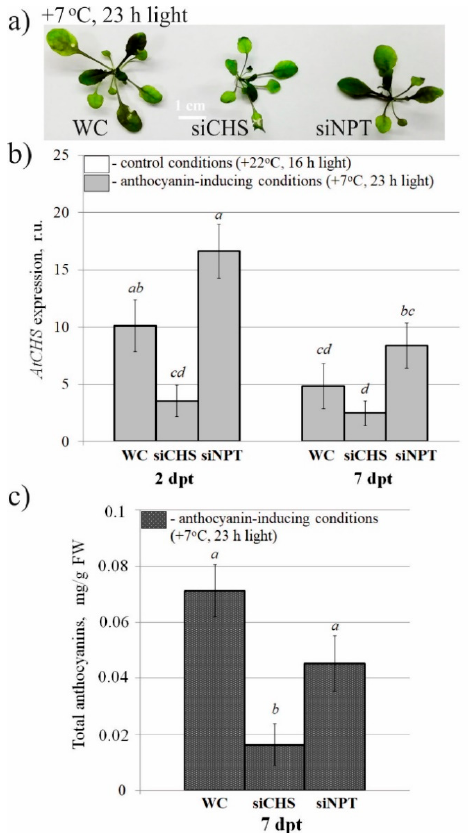
Figure 5. The effect of external AtCHS - and NPTII -encoding siRNAs on AtCHS mRNA level and total anthocyanin content in Arabidopsis thaliana . ( a ) Arabidopsis plants grown under control (+22 °C, 16 h light, upper panel) and anthocyanin-inducing (+7 °C, 23 h light, lower panel) conditions for seven days after treatment with sterile water or synthetic siRNA. ( b ) Quantitative real-time PCR measuring relative mRNA levels of endogenous AtCHS in the leaves of A. thaliana treated with water or synthetic siRNAs. ( c ) HPLC results of the total anthocyanin content in the leaves of A. thaliana grown at the control and anthocyanin-inducing conditions. WC— A. thaliana treated with sterile water; siCHS— A. thaliana treated with synthetic AtCHS -siRNAs; siNPT— A. thaliana treated with NPTII -siRNA; dpt—days post-treatment. The data are presented as the mean ± SE (three independent experiments). Means followed by the same letter were not different using Student’s t test. p < 0.05 was considered statistically